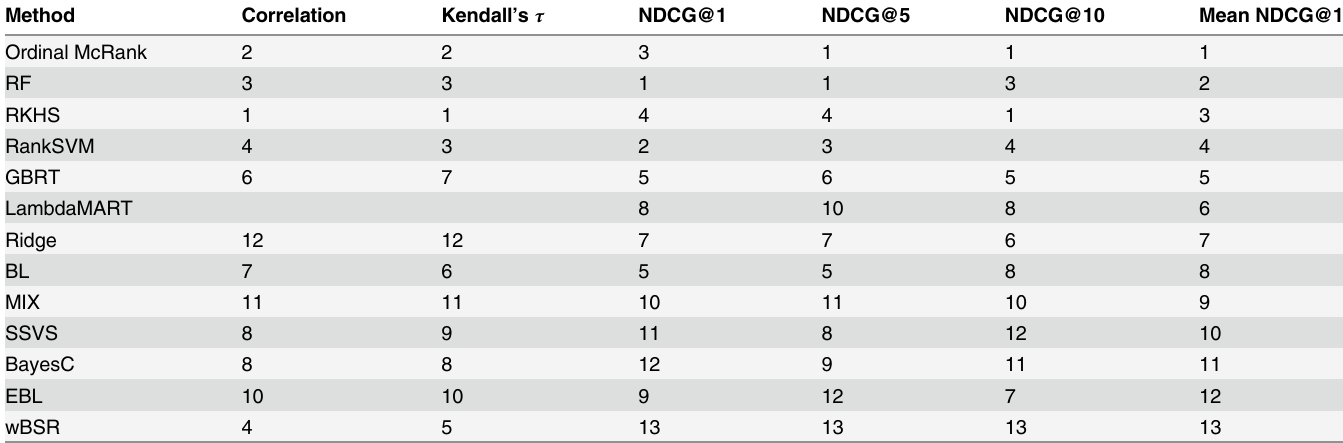
Table 1. General method ranking, obtained by sorting methods according to their average ranking across 6 datasets. Method